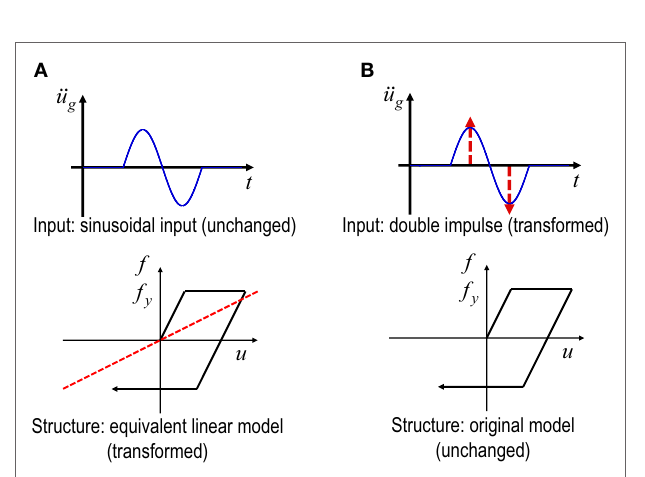
FigUre 2 | Feature of method of input transformation against method of structural model transformation: (a) previous method (equivalent linearization of structural model for unchanged input) and (B) new method (transformation of input into double impulse for unchanged structural model)